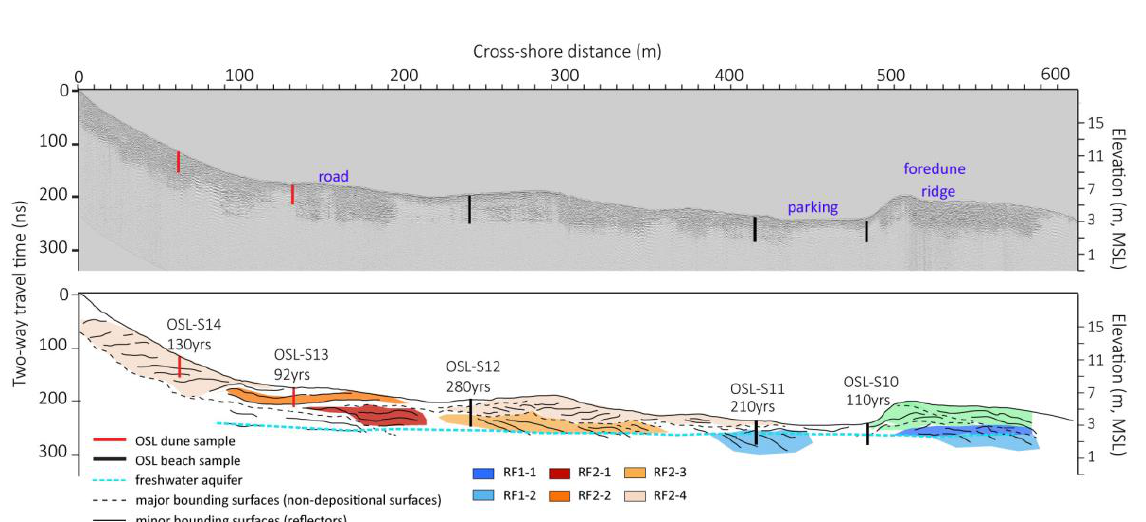
Figure 5. The upper panel shows the radargram corresponding to GPR-NT (i.e., northern transect in Figure 3) measured across the coastal plain at Fonte da Telha. The lower panel presents the interpretation of the radargram showing identified radar facies, the position of the sediment samples for dating and their ages.